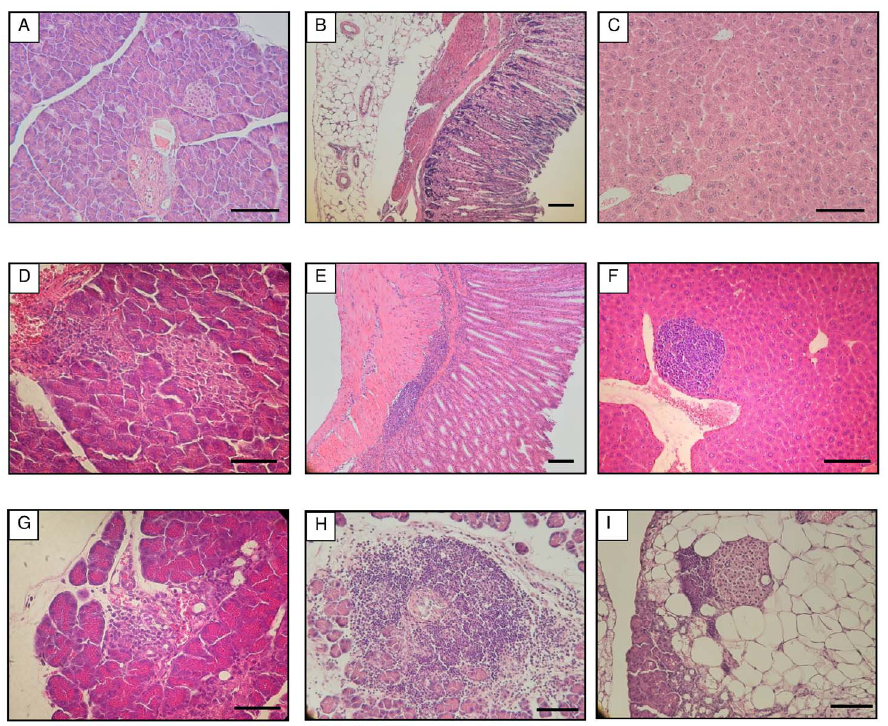
Figure 1. H&E-stained tissues of WT and Aire KO mice. A-C, pancreas, stomach and liver, respectively, from 12-wk-old WT mice. D-F, pancreas, stomach and liver, respectively, from 12-wk-old Aire KO mice. G, pancreas from 6-wk-old Aire KO mice. H and I, pancreas from 24-wk-old Aire KO mice. Each bar represents 100 m m.